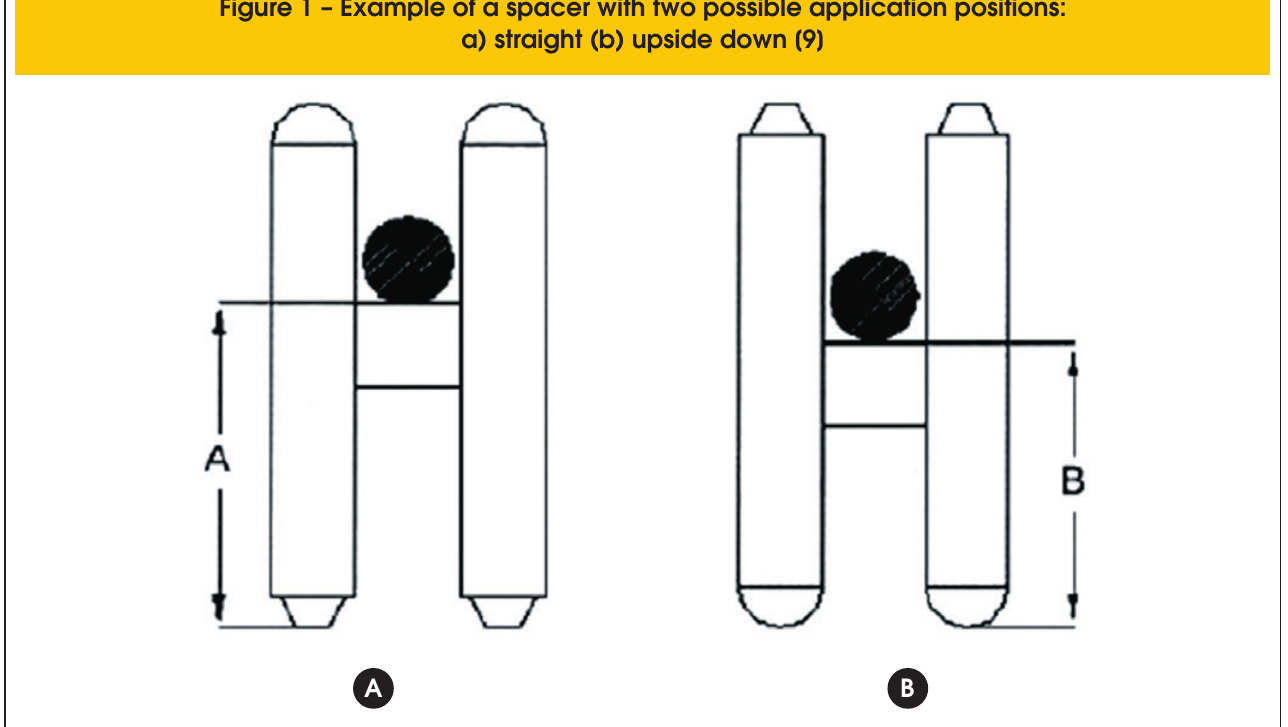
Figure 1 – Example of a spacer with two possible application